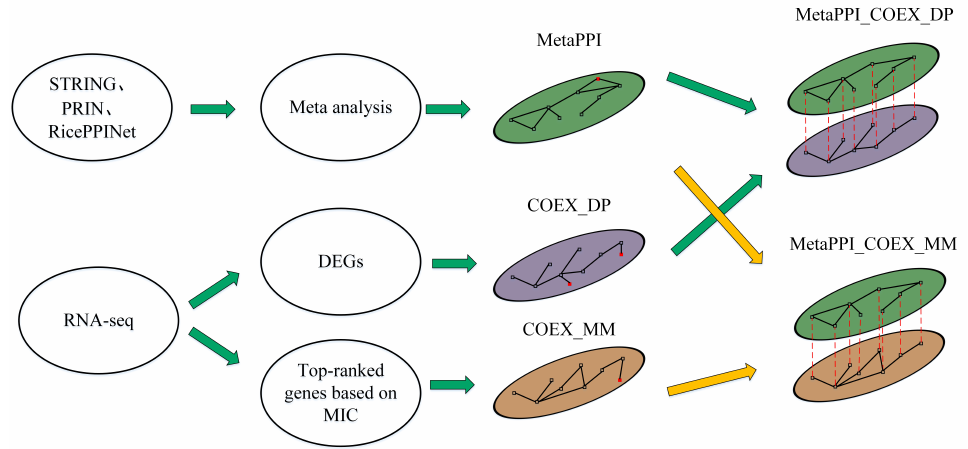
Figure 1. The network’s construction process. In the process of network convergence, we retained the intersection of nodes across the PPI and coexpression networks. A node removed was color-coded